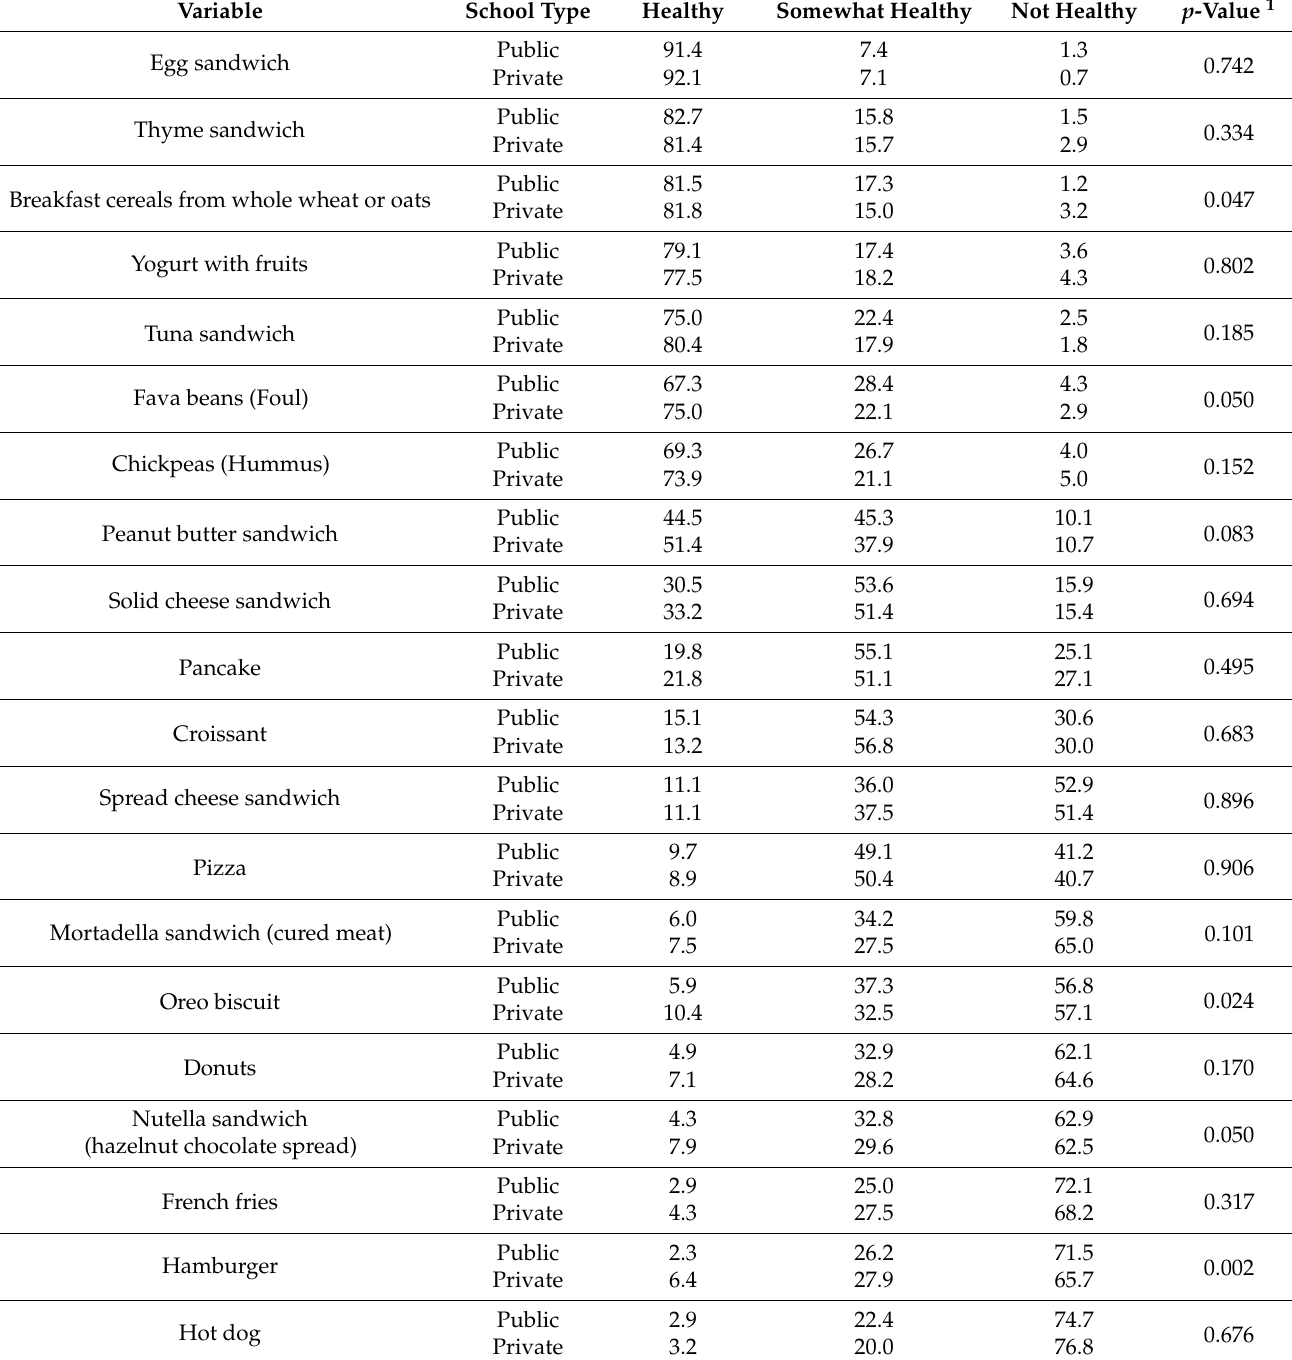
Table 6. Chi-square tests for significant differences in the proportions between public and private schools.